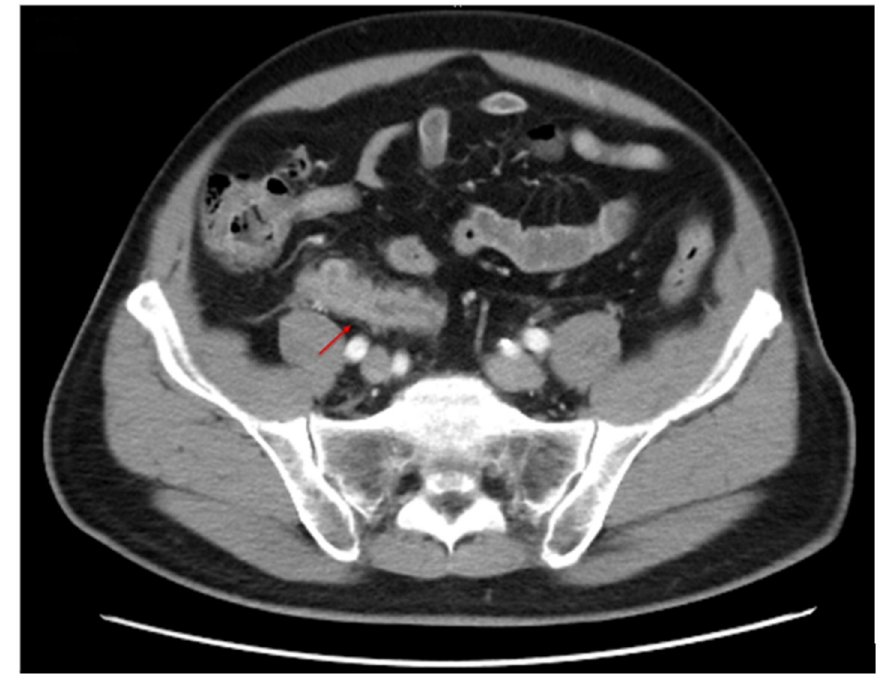
Figure 1. Periappendiceal fatty stranding and enlarged appendix (arrow).